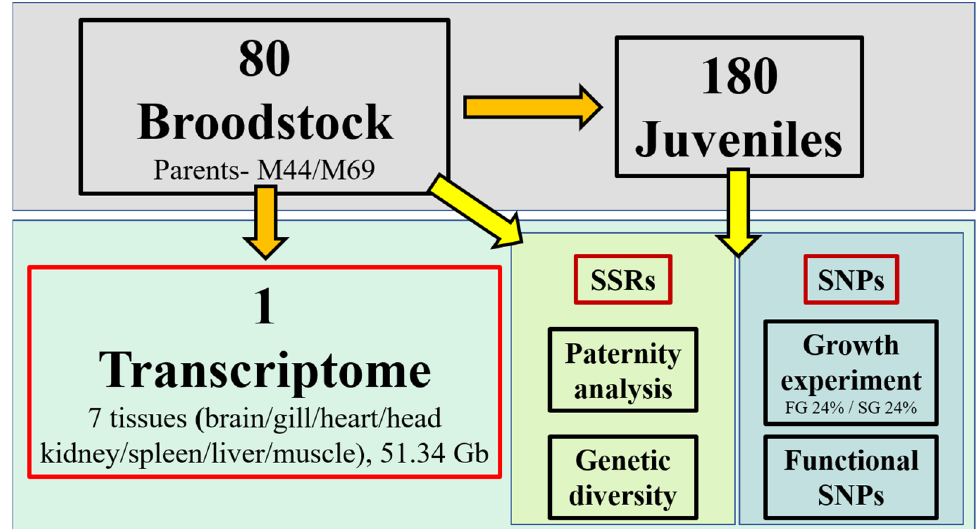
Figure 1. Experimental diagram showing the identification of molecular markers ideal for genetic management (parentage analysis and genetic diversity) and marker-assisted selection (MAS) of potato groupers. 80 broodstock individuals of potato grouper were tagged and cultured. A mature potato grouper was randomly chosen for transcriptome analysis. Seven tissues (the brain, gill, heart, head kidney, spleen, liver, and muscle) were collected for RNA sequencing. 180 juveniles were used for growth experiments and divided into two groups: the fast-growth group (top 24%; FG) and the slow-growth group (bottom 24%; SG). Simple sequence repeats (SSRs) were used for paternity analysis and genetic diversity; single nucleotide polymorphisms (SNPs) were used for the growth experiment and functional SNPs. Parents- M44/M69 represents the tagged id of brood- stock.